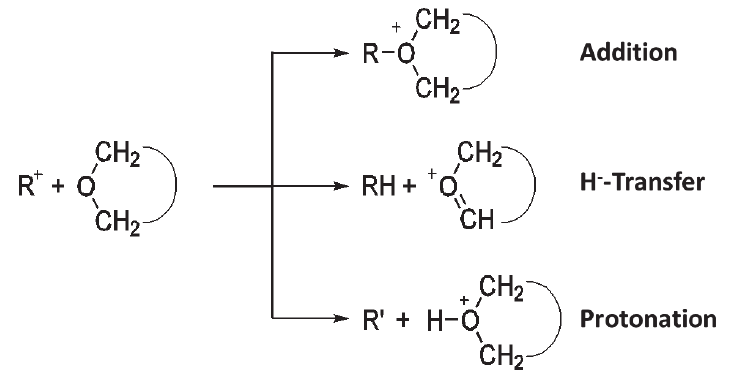
Figure 17. General structure of heteroatom